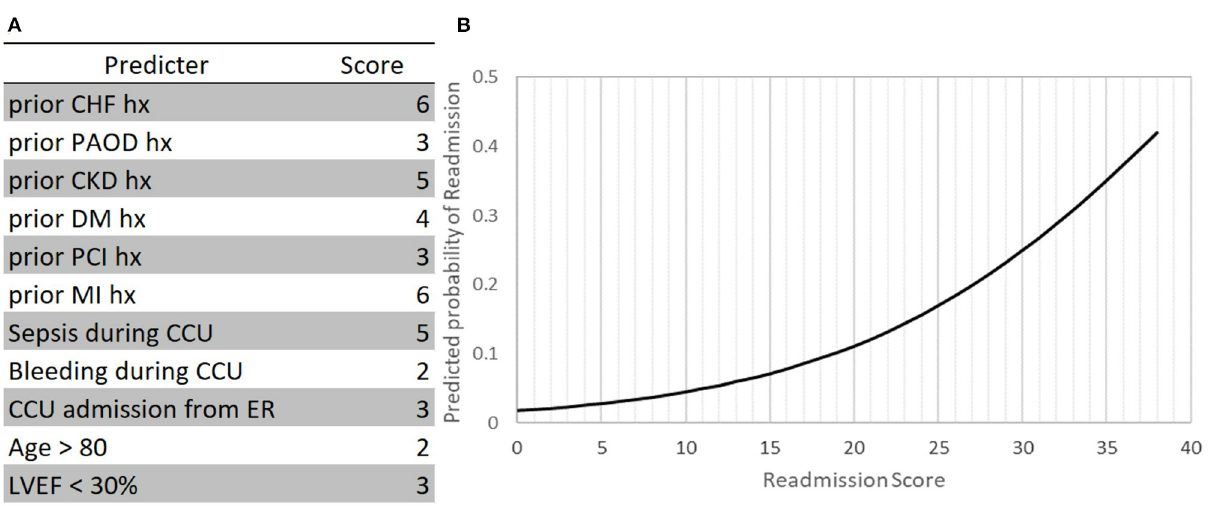
FIGURE 2 | CCU readmission risk score model nomogram. (A) The CCU readmission risk score and (B) mean predicted CCU readmission by CCU readmission risk score. CCU, coronary care unit; CHF, congestive heart failure; PAOD, peripheral artery occlusive disease; CKD, chronic kidney disease; DM, diabetes mellitus; PCI, percutaneous coronary intervention; MI, myocardial infarction; LVEF, left ventricular ejection